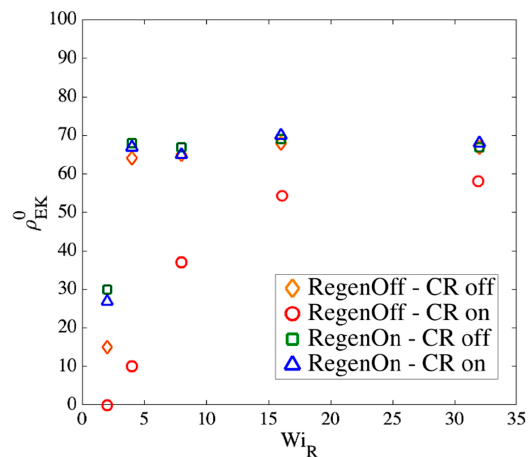
Figure 19. The same as Figure 15, except for the entanglement density ( ρ 0 EK